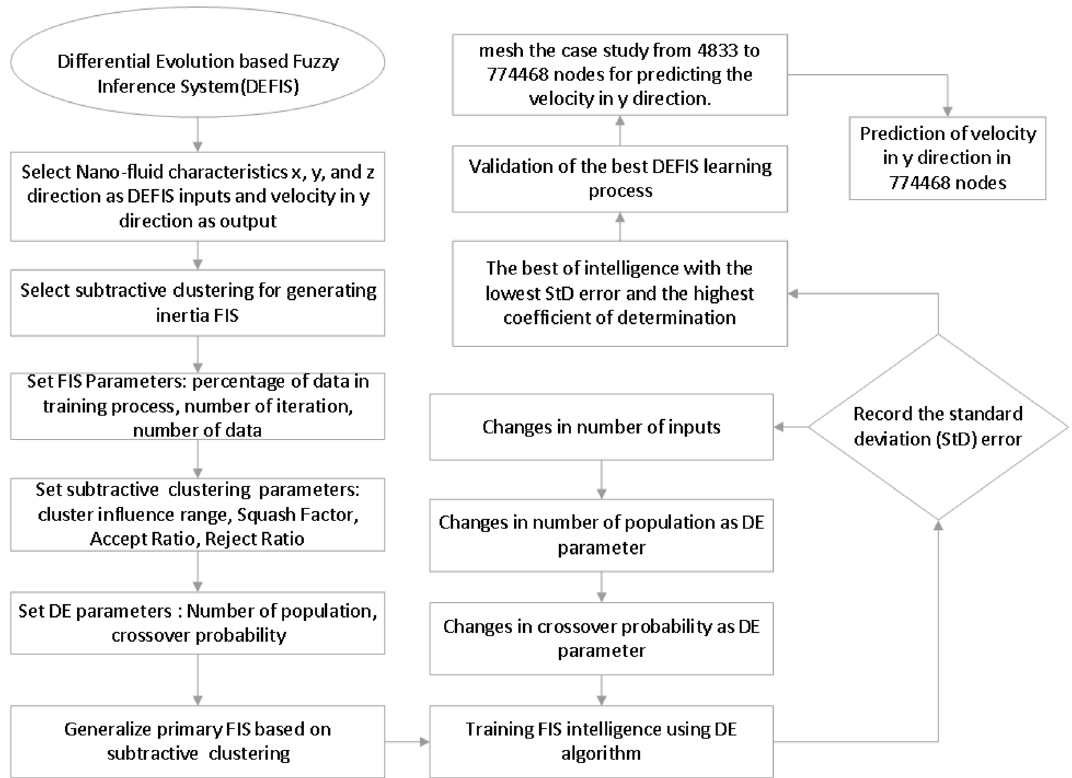
Figure 1. Flowchart of DEFIS method employed in this work.